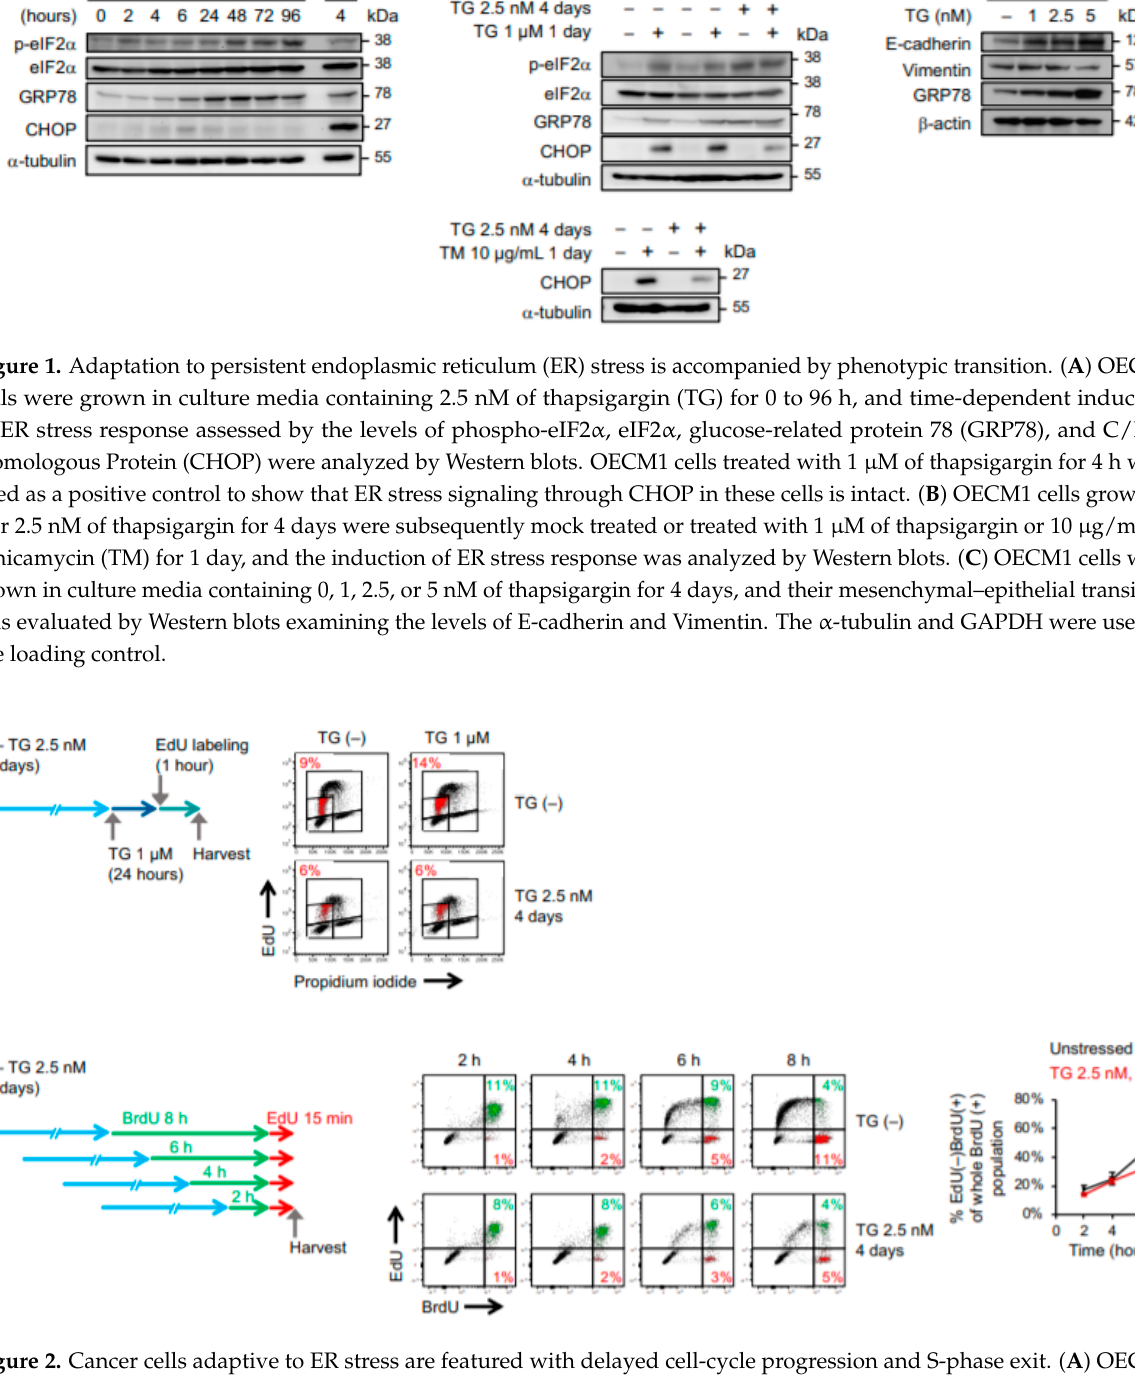
Figure 2. Cancer cells adaptive to ER stress are featured with delayed cell-cycle progression and S-phase exit. ( A ) OECM1 cells with or without 4 days of 2.5 nM thapsigargin pretreatment were treated with 1 µM of thapsigargin for 1 day and subsequently labeled with 5-ethynyl-2-deoxyuridine (EdU) for 1 h. Flow cytometry analysis of cell-cycle subpopulations (G 1 , S, and G 2 phases) on the basis of EdU incorporation and propidium iodide (PI) staining for DNA content was used to reveal cell population of early-S phase labeled in red. ( B ) OECM1 cells with or without 4 days of 2.5 nM thapsigargin pretreatment were sequentially labeled with 5-bromo-2 ′ -deoxyuridine (BrdU) for 2 to 8 h and EdU for 15 min. The rate of S-phase exit was assessed by the percentage of EdU( − )BrdU(+) of whole BrdU(+) populations measured by flow cytometry analysis. Data from one representative experiment was shown. The mean ± SEM (three independent experiments) of EdU( − )BrdU(+) percentage was plotted. Statistical significance was determined by one-way ANOVA. *, p < 0.05.